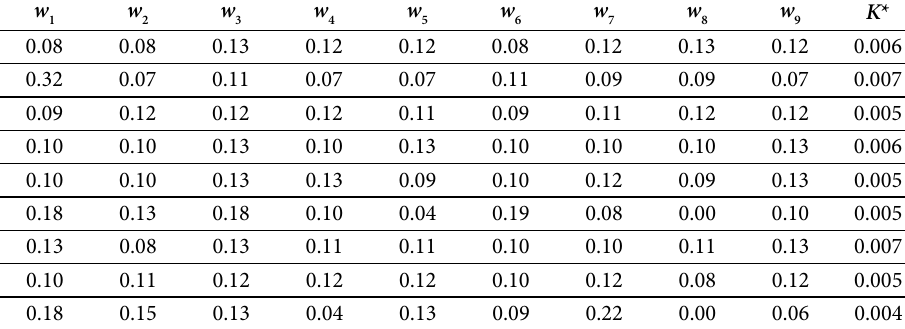
Table 4. Weights of criteria preserving the